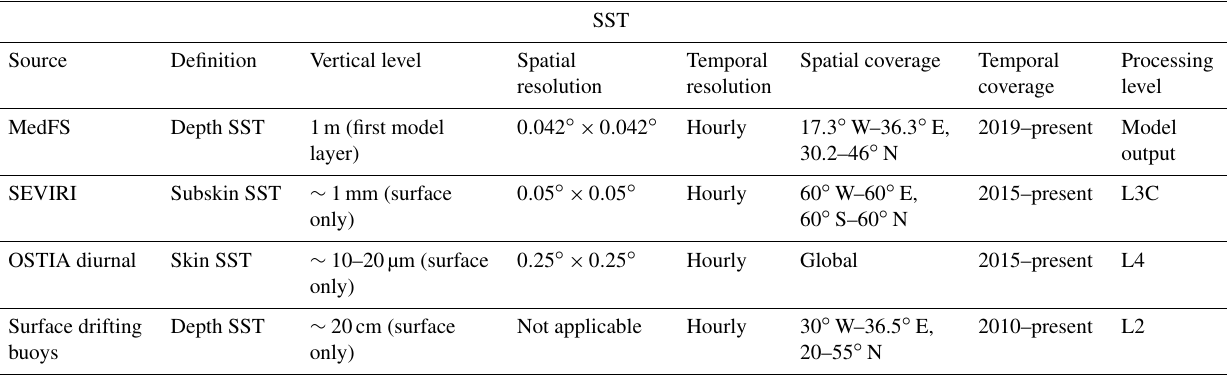
Table 1. Summary of the SST products used to produce (MedFS and SEVIRI), validate (surface drifting buoys), and intercompare (all) the DOISST product. The SST nomenclature (skin, subskin, and depth) follows the GHRSST definitions